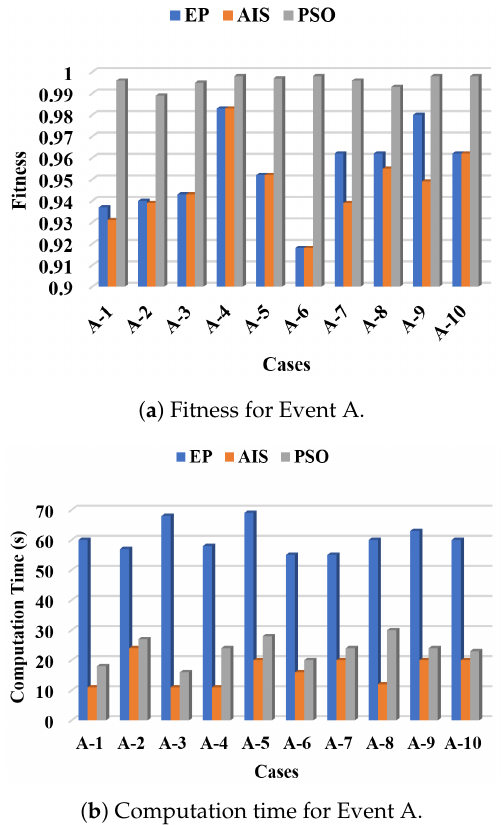
Figure 7. Fitness and computation time for Event